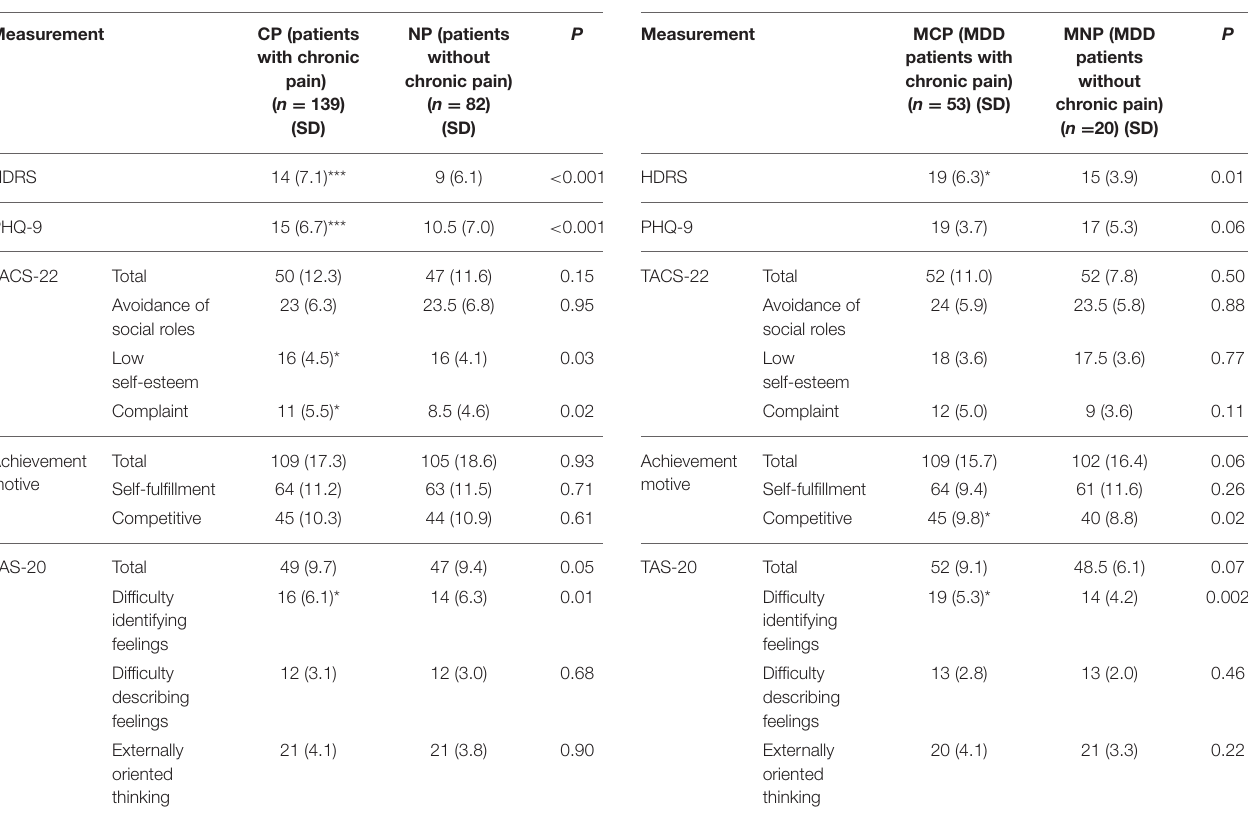
MNP (MDD patients with chronic pain) ( n = 53) (SD)